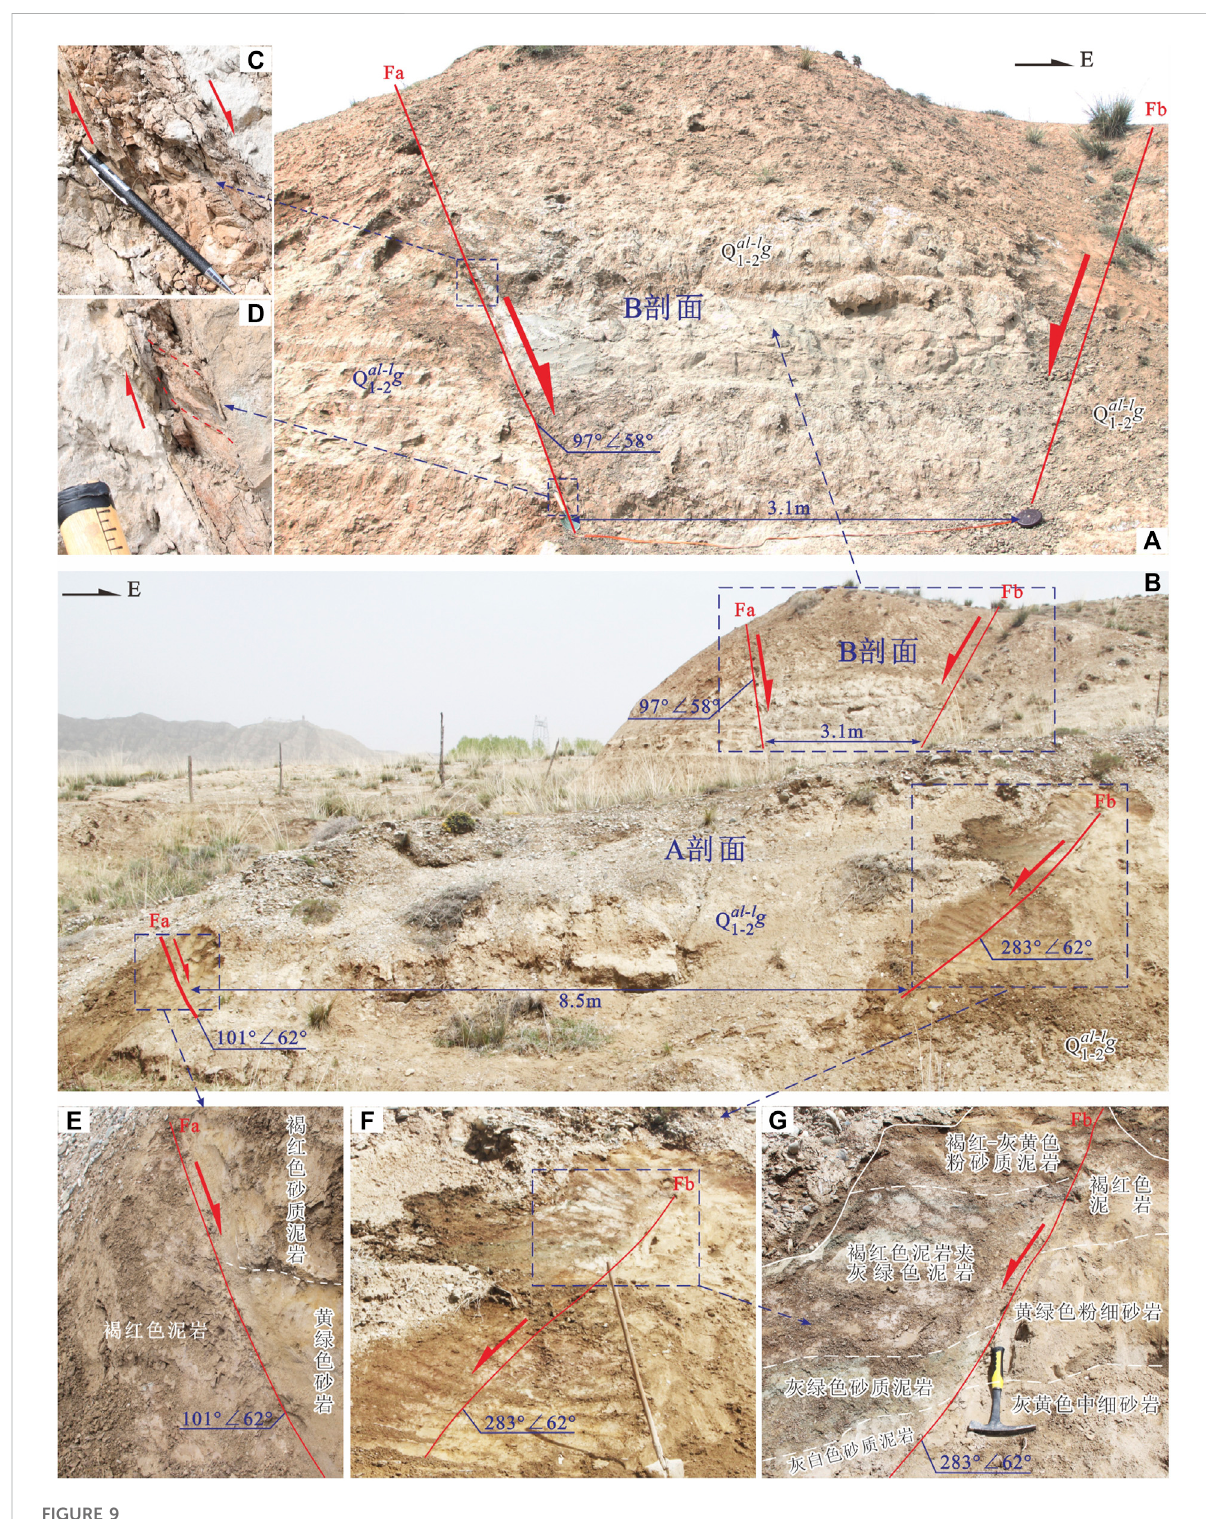
FIGURE 9 Graben-type normal fault framework north of Deliji village